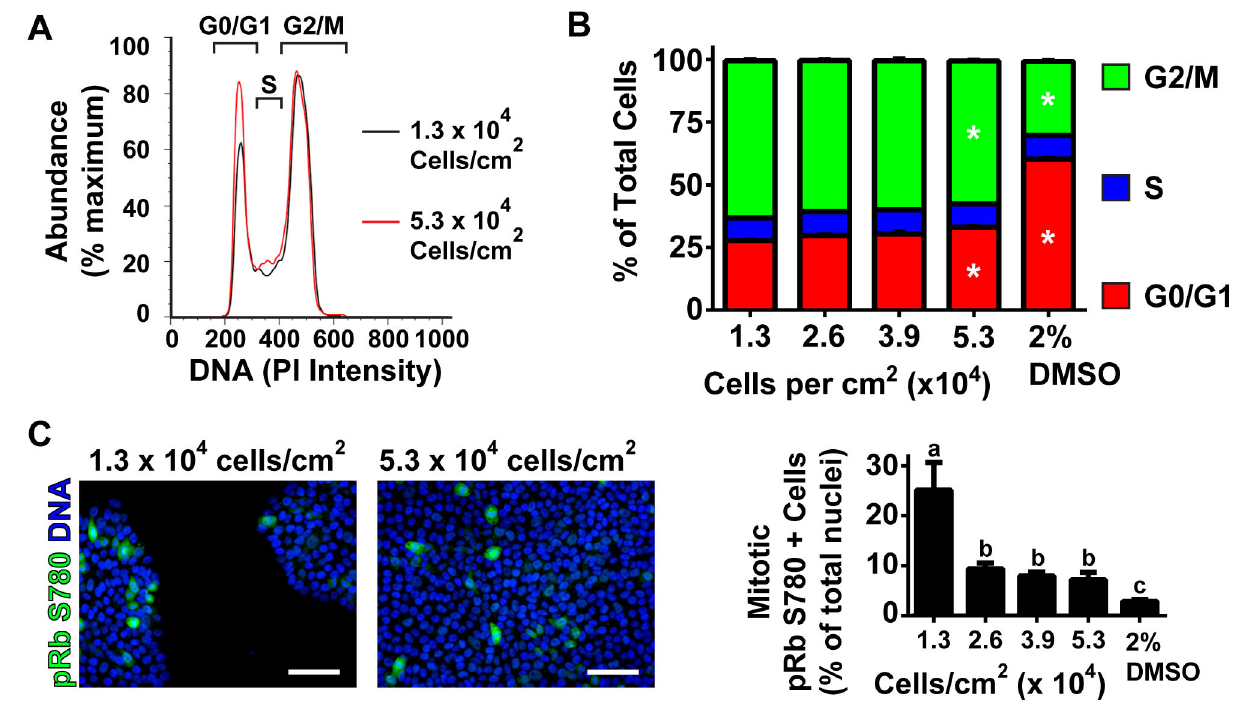
Figure 2. Higher Cell Seeding Density Decreases Cell Cycle Progression. (A) A representative histogram (left) of low density (1.3 x 10 4 cells/cm 2 , black line) and high density (5.3 x 10 4 cells/cm 2 , red line) seeded CA1S hESCs stained for DNA content by propidium iodide to indicate cell cycle state within the depicted gates 24-hours after seeding. (B) Single cells gated for uniform DNA width were assessed in triplicate and quantified as either G0/G1, S or G2/M phases using the gates in (A) as a percentage of the total single cell population. Four cell seeding densities of CA1S cells (1.3, 2.6, 3.9 and 5.3 x 10 4 cells/cm 2 ) along with 5.3 x 10 4 cells/cm 2 seeded cells treated overnight with 2% DMSO to induce cell cycle arrest (2% DMSO) were quantified. * represents significant difference from 1.3 x 10 4 cells/cm 2 by one-way ANOVA with Bonferroni post-hoc test within the same cell cycle population. (C) Representative images and quantification of immunocytochemistry of pRb S780 (green, nuclei are blue). pRb S780 positive mitotic cells were quantified as a percentage of the total cell populations in five randomly selected images. Different superscripts (a, b, c) are significantly different from each other by one-way ANOVA with Bonferroni post-hoc test. Scale bars are 100